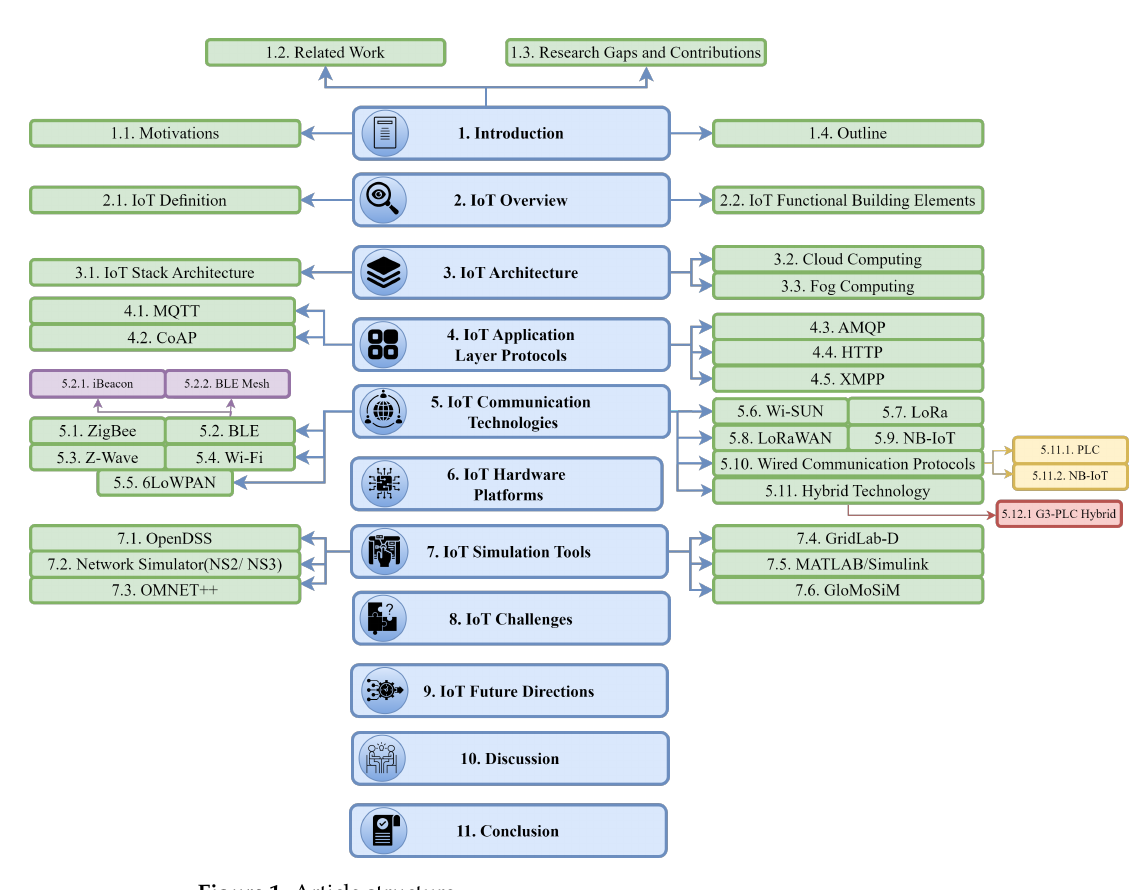
Figure 1. Article